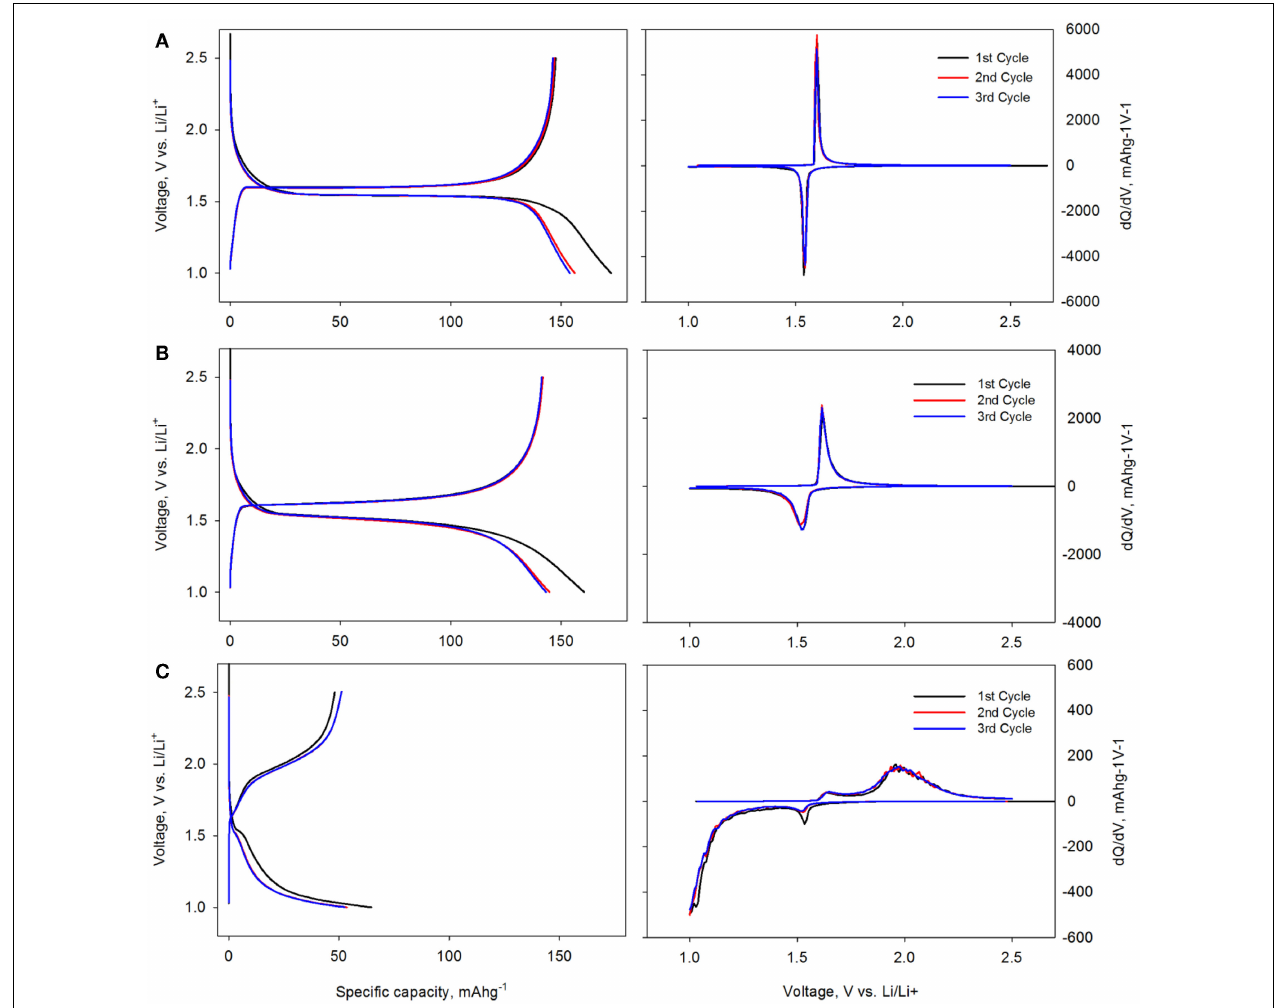
FIGURE 3 | Voltage profile (left) and differential capacity plot (right) of the pristine LTO (A), 2.2nm Al 2 O 3 -coated LTO (B) and 5.5nm Al 2 O 3 -coated LTO (C) electrode with normal potential window from 2.5 to 1V vs. Li/Li +